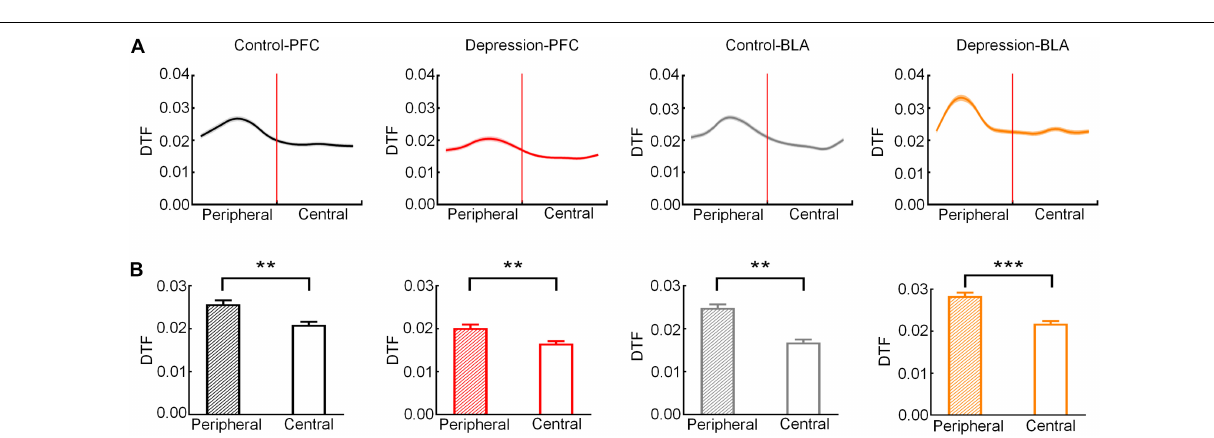
FIGURE 4 | Direct transfer function (DTF) in the mPFC and BLA of the control and depression groups in the peripheral and central zones. (A) Averaged DTF in the theta band from the peripheral to the central zone. The red line represents the RP. (B) Comparison of averaged theta band DTF in peripheral and central zone. Error bars indicate SEM. Paired sample t -test, ** p < 0.01, *** p <